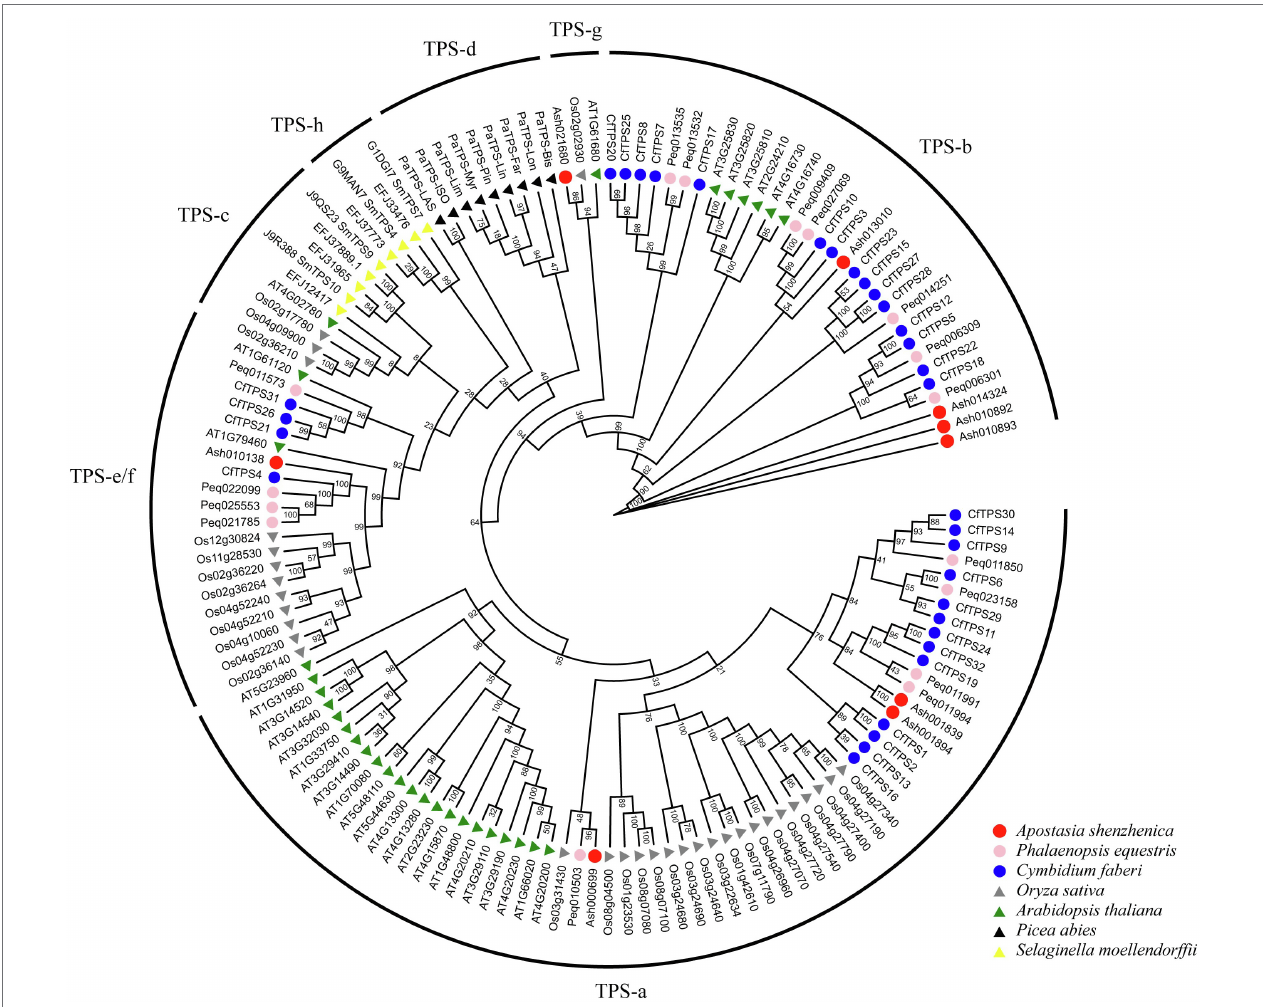
FIGURE 3 | Phylogenetic tree of CfTPS genes based on the TPS protein sequences of seven plant species. The ML method was used for the phylogenetic tree, which was constructed with RAxML on the CIPRES Science Gateway web server (RAxML-HPC2 on XSEDE; Miller et al., 2011). The bootstrap values were 1,000 replicates with the JTT model. The generated tree was redrawn and annotated by the EVOLVIEW website (He et al., 2016). The TPS family was classified into seven categories: TPS-a, TPS-b, TPS-c, TPS-d, TPS-e/f, TPS-g, and TPS-h (Chen et al., 2011). TPS protein sequences in Cymbidium faberi are available in Supplementary Table S7